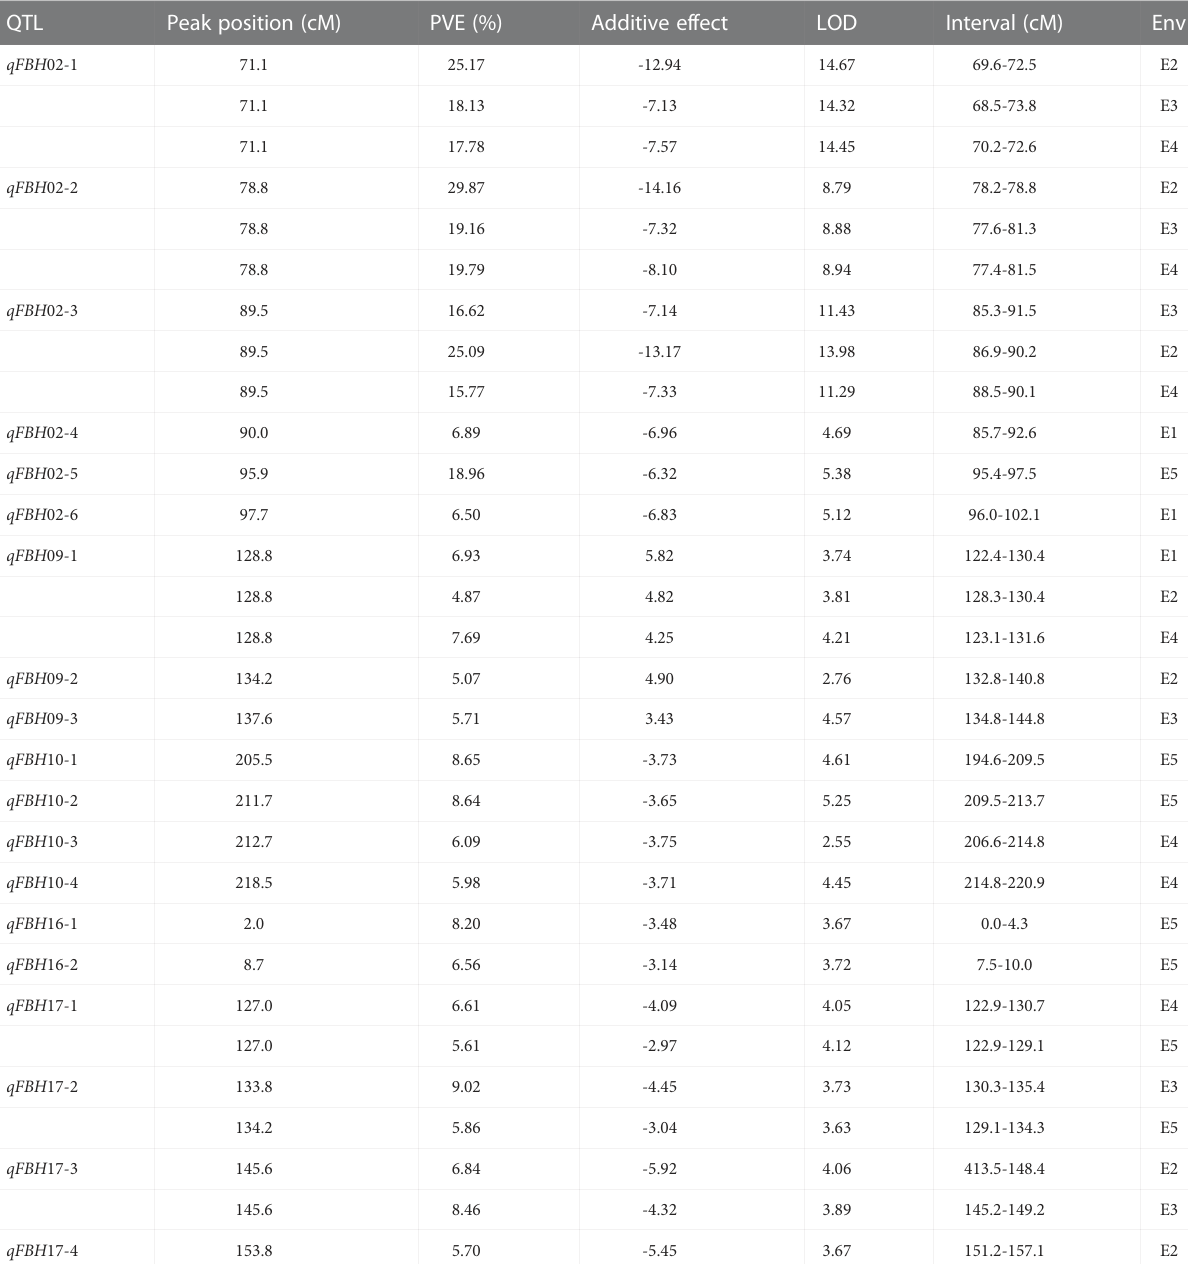
TABLE 2 Putative QTLs for rapeseed FBH in RIL population under different environments. QTL Peak position (cM) PVE (%) Additive effect LOD Interval